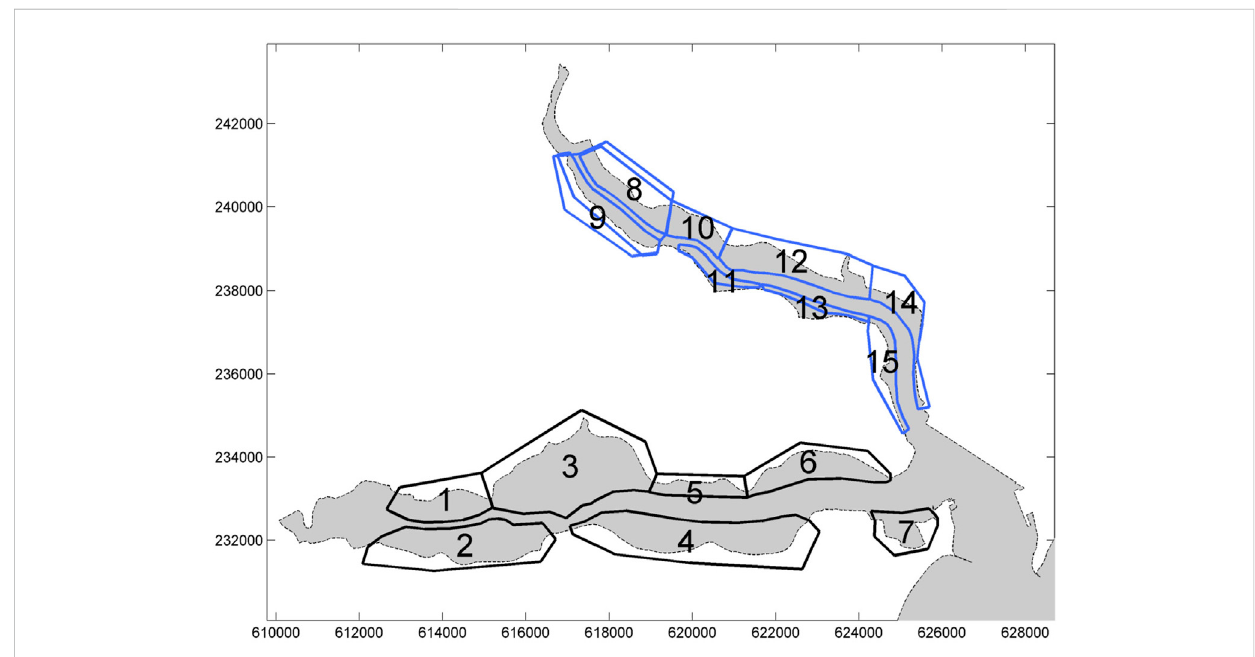
FIGURE 11 Zones used in comparisons between surveys and modelling of the intertidal erosion/deposition rate throughout the estuary